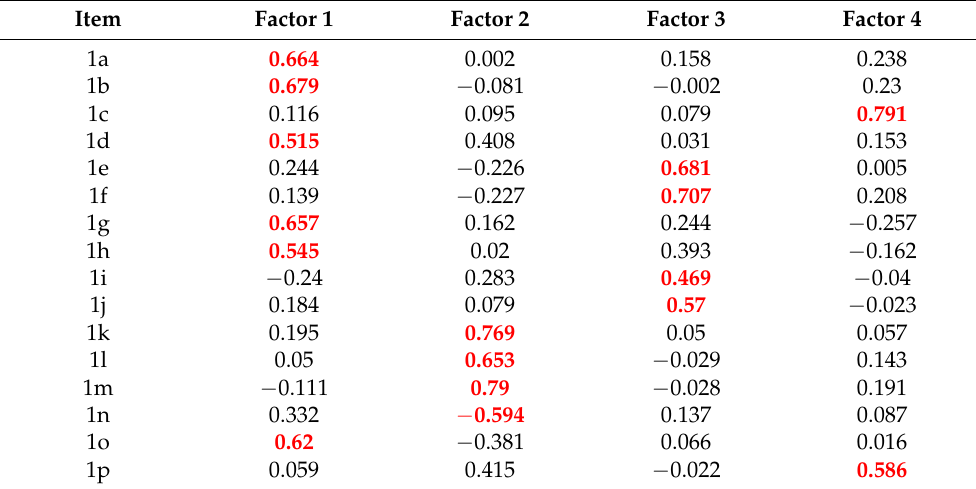
Table 4. Factor loadings of exploratory factor analysis (EFA) with principal components method and varimax rotation. Item